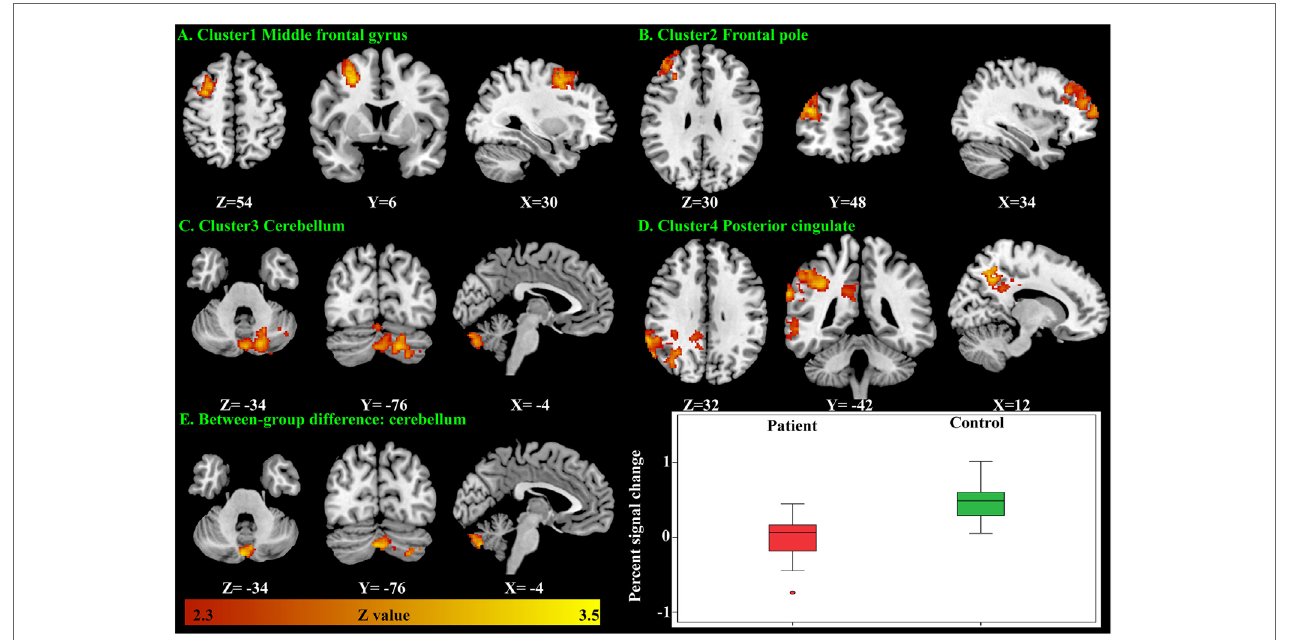
FigUre 4 | Significant brain activation responding to the sad distractor contrast in the male adolescents. Significant mean activation (a–D) and significant case– control difference of these mean activation regions (e) . A box plot showed higher brain activation (extracted percent signal change) in the male controls’ cerebellum when compared with the male patients.